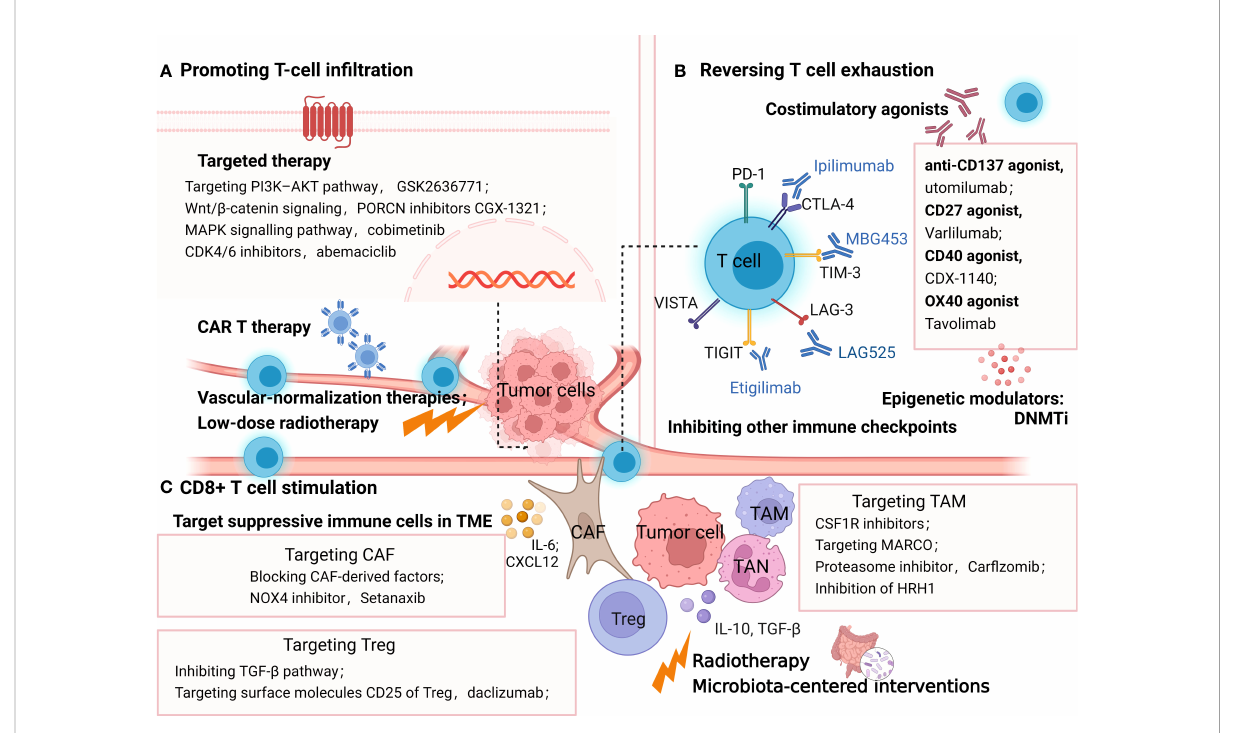
FIGURE 4 Strategies overcoming resistance to PD-1/PDL1 by promoting T-cell in fi ltration (A) , reversing T cell exhaustion (B) , and CD8+ T cell stimulation (C) . (A) methods promoting T-cell in fi ltration include targeted therapy, vascular-normalization therapies, CAR T therapy and low-dose radiotherapy; (B) treatment options to reinvigorate of T cell exhaustion include blocking the alternative immune checkpoints, targeting co-stimulatory receptors, inhibiting soluble immune suppressive mediators and epigenetically coordinating exhausted CD8+ T (Tex) cells. (C) strategies targeting immune- suppressive cells in TME such as TAM, Treg and CAF to stimulate T cells. In addition, radiotherapy and microbiota-centered interventions also reprogram the immunosuppressive TME, promoting antitumor T-cell responses. The picture was created with BioRender.com. CAR, chimeric antigen receptor, Treg, regulatory T lymphocytes; DC, dendritic cell; TAM, tumor associated macrophages; CAF, cancer associated fi broblasts; MARCO, macrophage receptor with collagenous structure; HRH1, histamine and histamine receptor